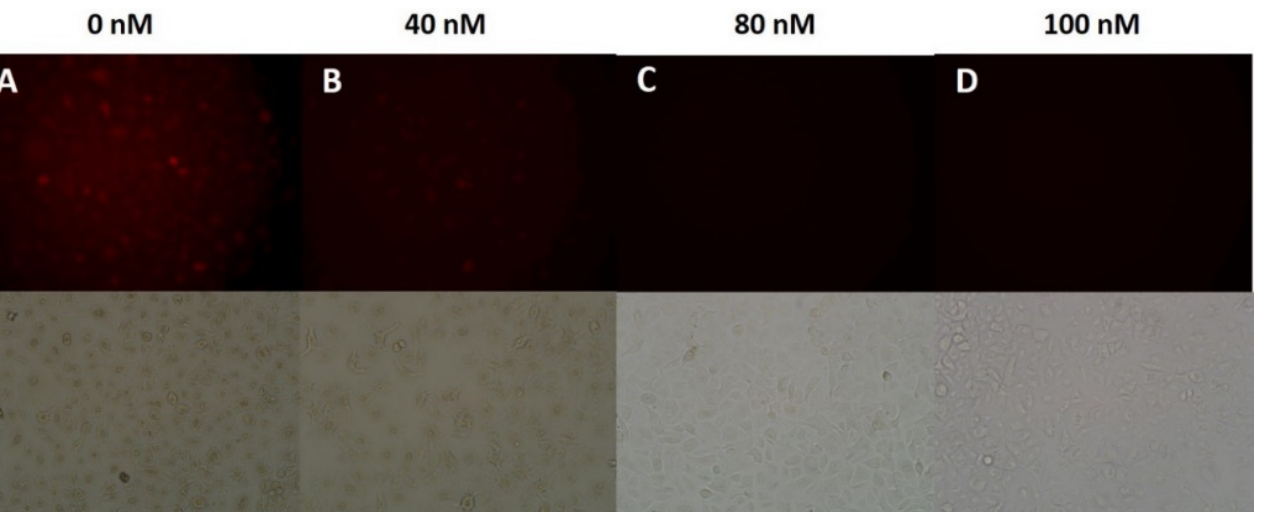
Figure 9. Confocal laser scanning microscopy of HeLa cells co-stained with mPEG-b-P(PA-alt-AG- ERh) nanosensor (5 μ M) and LysoSensors Green DND-189 (1 μ M). ( A ) Green emission of LysoSen- sors Green DND-189; ( B ) Red emission of mPEG-b-P(PA-alt-AGERh) nanosensor; ( C ) overlay of ( A ) and ( B ); and ( D ) a bright field image. Excitation wavelength of mPEG-b-P(PA-alt-AGERh) nanosen- sor and LysoSensors Green DND-189 was 560 nm and 488 nm, respectively.